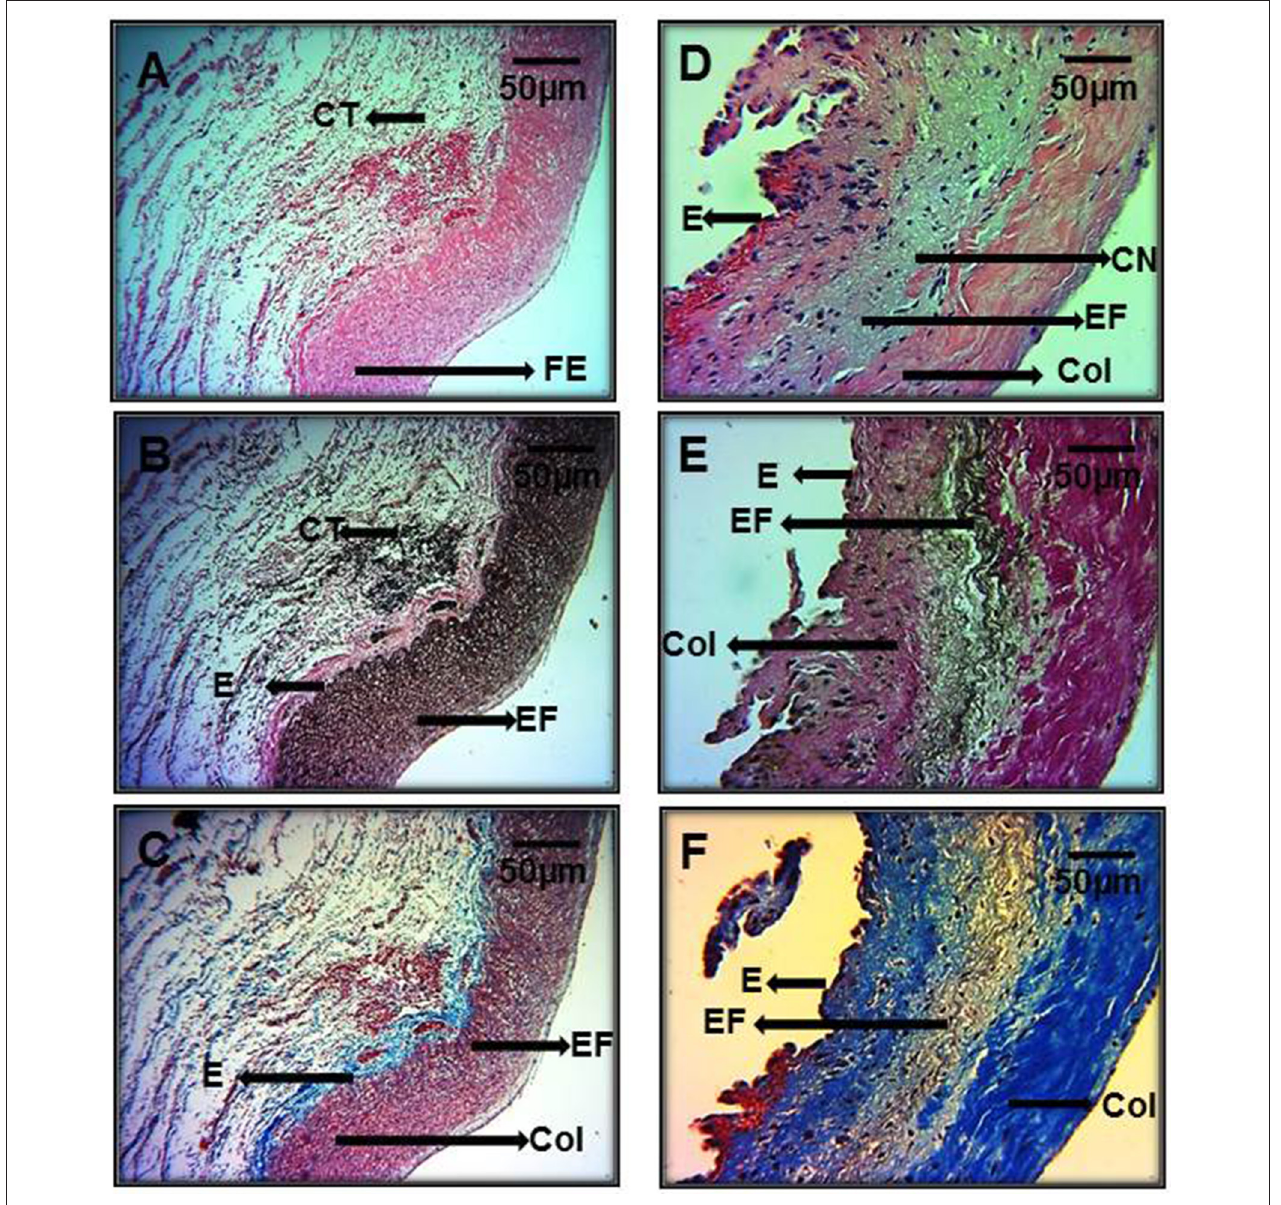
FIGURE 5 | Representative photomicrographs of the aortic root in control subjects (A–C) vs. aortic root aneurysms in MFS patients (D–F) . Sections were stained with different histological techniques Hematoxylin-eosin, Masson’s, and Weigert methods respectively. E, Endothelium; EF, elastic fibers; Col, collagen; CT, connective tissue; CN, cystic necrosis. 16x